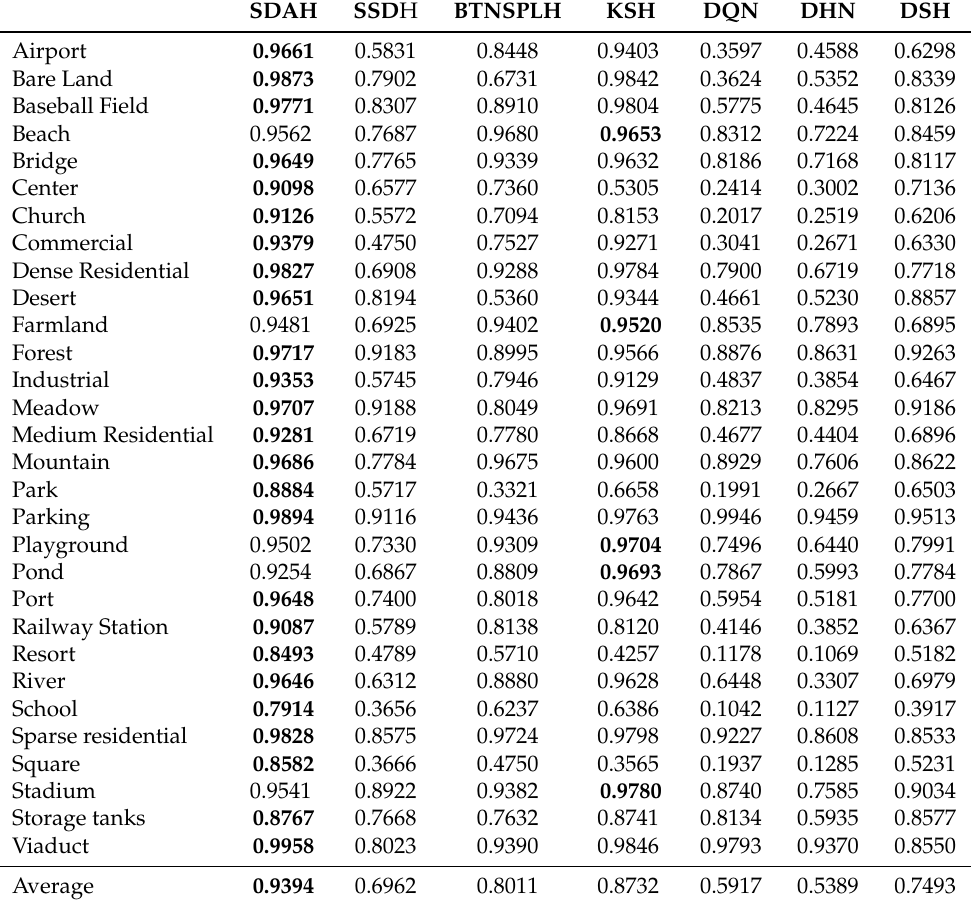
Table 8. Retrieval Mean average precision of different hash learning methods across 30 semantic categories in AID archive counted by Top 50 results. The retrieval results are obtained by the hash codes with 128 bits. The values in bold mean that highest mean average precision of different